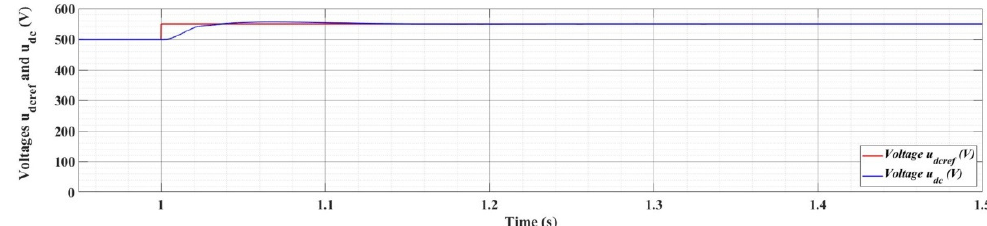
Figure 34. The time evolution of the u dc voltage for a step variation of the u dcref reference voltage from 500 V to 550 V using PI controllers and the RL-TD3 agent for the correction of the i dref command (signal evolution of the type 1 PV array).